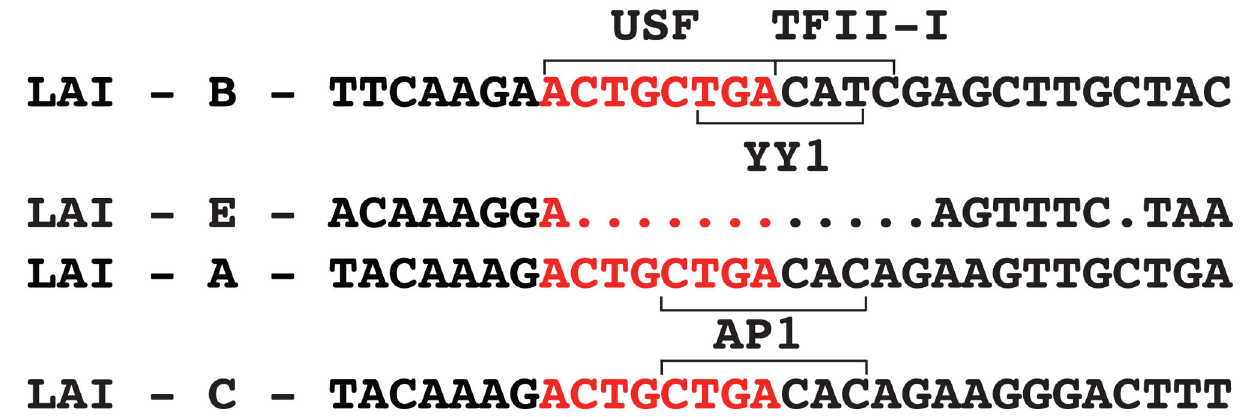
Figure 7. Multiple transcription factors, including YY1, directly bind near the conserved RBEIII element. The RBEIII sequence (red) and flanking sequences are shown, indicating the positions bound by USF1/2, TFII-I and YY1. Sequence variations observed in HIV-1 subtypes LAI-B (pTY-LAI-dsRed), LAI-A, LAI-C and LAI-E are indicated. A binding site for AP1 identified in subtypes A and C is indicated [34]. doi: